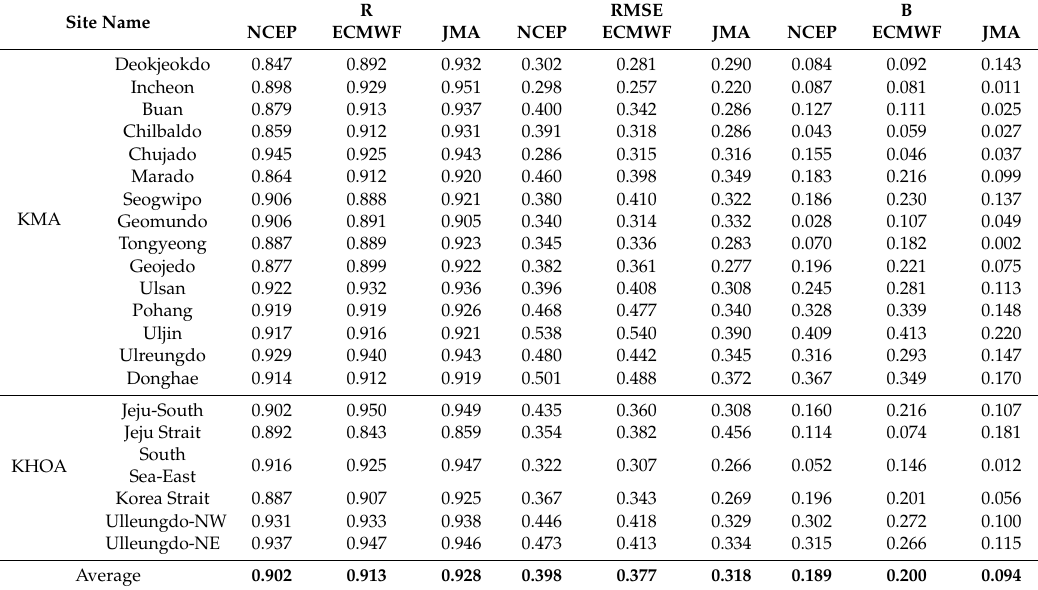
Table 4. Wind product verification results at wave observation stations.